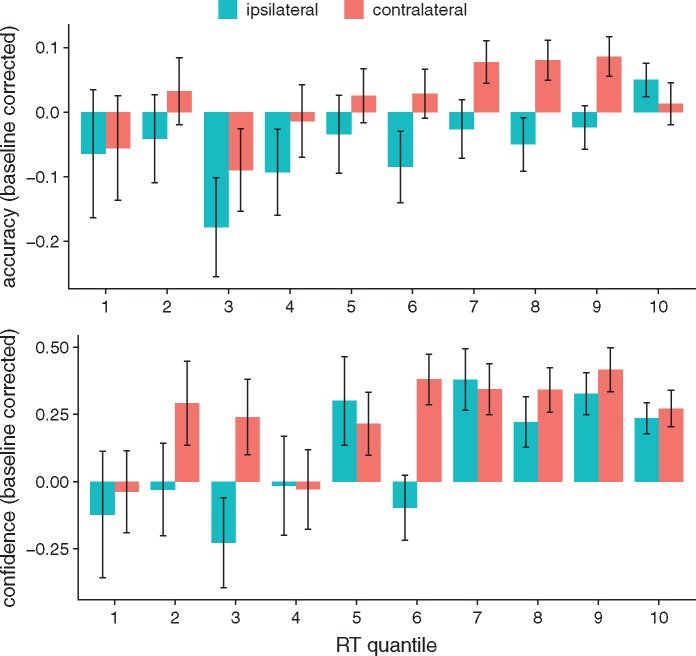
Mean accuracy (top panel) and confidence (bottom panel) by RT quantiles across subjects with partial activation ipsilateral (blue) or contralateral (red) to the response, baseline-corrected with respect to trials without partial activation. Error bars reflect standard errors of the mean.